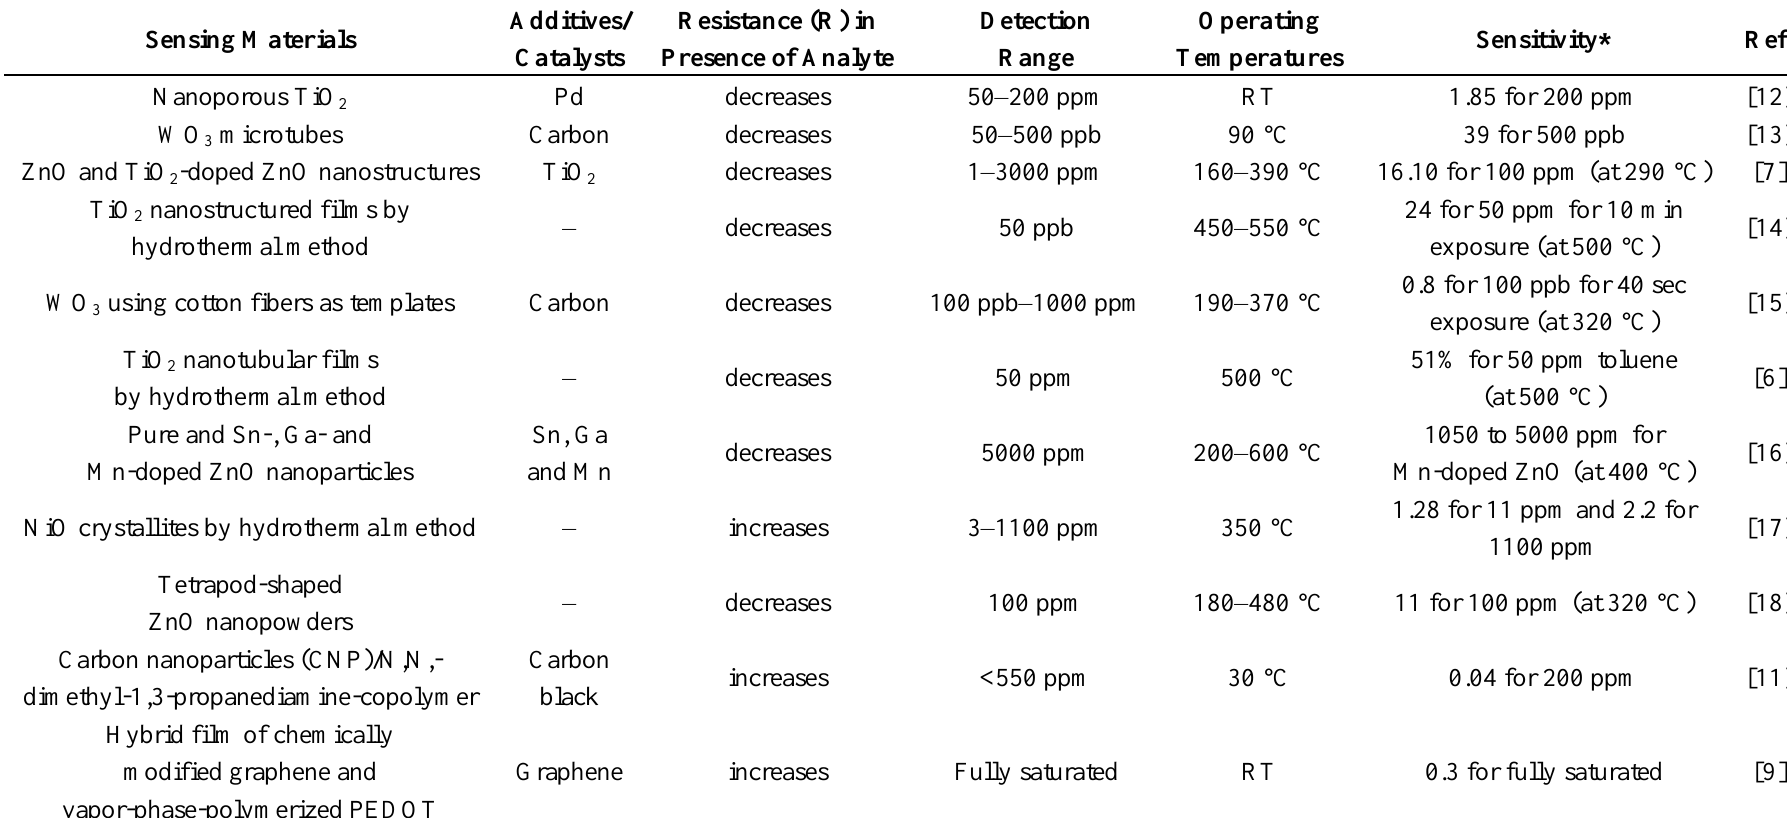
Table 1. Toluene sensing using resistive gas sensor with different sensing